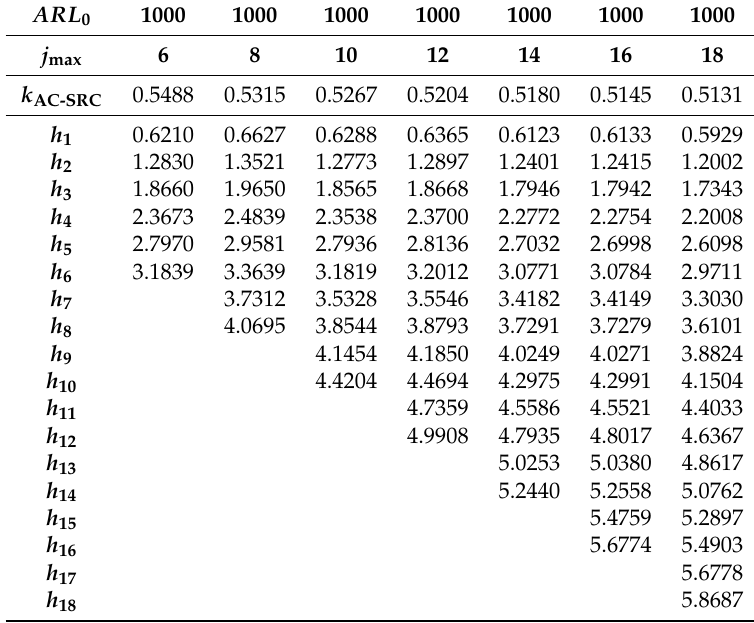
Table A11. AC-SRC for ARL 0 =